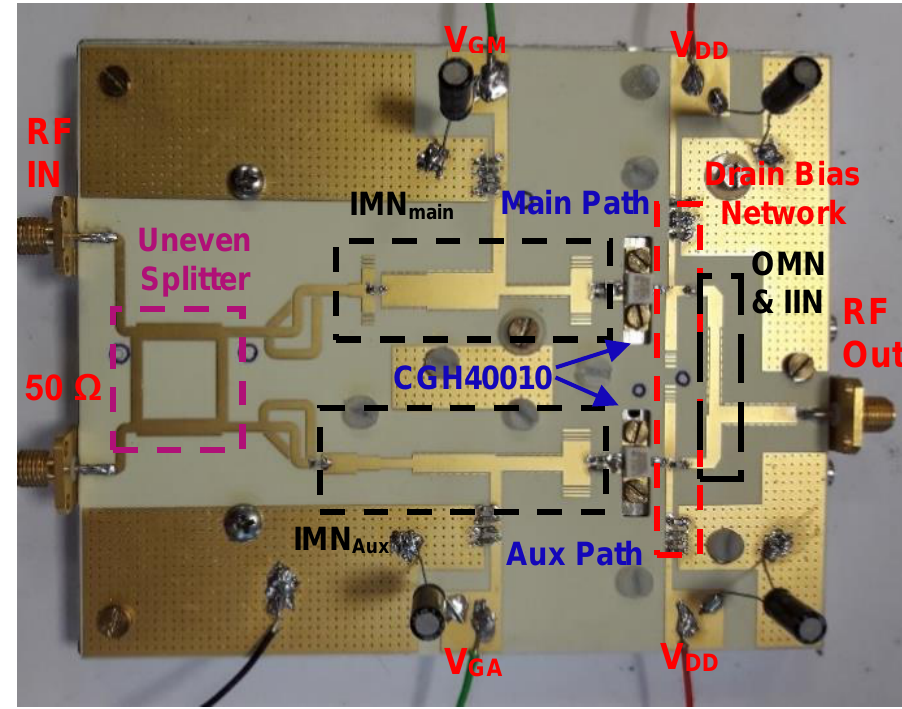
Figure 13. Photograph of the fabricated Doherty power